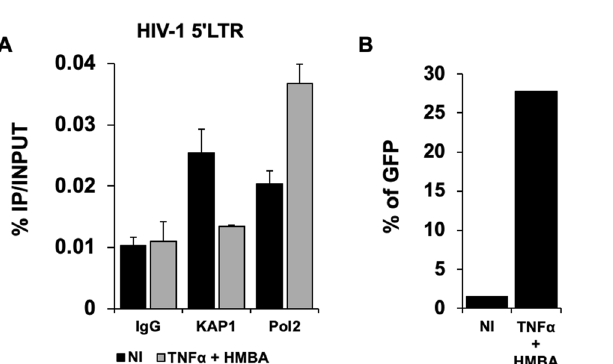
Figure 2. KAP1 binds to the latent HIV-1 promoter ( A ) Microglial cells latently infected with HIV-1 containing the GFP reporter gene were treated for 24 h with TNFα and HMBA. Cells were subjected to ChIP- qPCR experiments targeting the binding to the HIV-1 5 ′ LTR promoter ( B ) The same microglial cells were also analyzed by flow cytometry. The results are presented as percentages of immunoprecipitated DNA compared to the input DNA (% IP/INPUT). This figure is representative of 3 independent